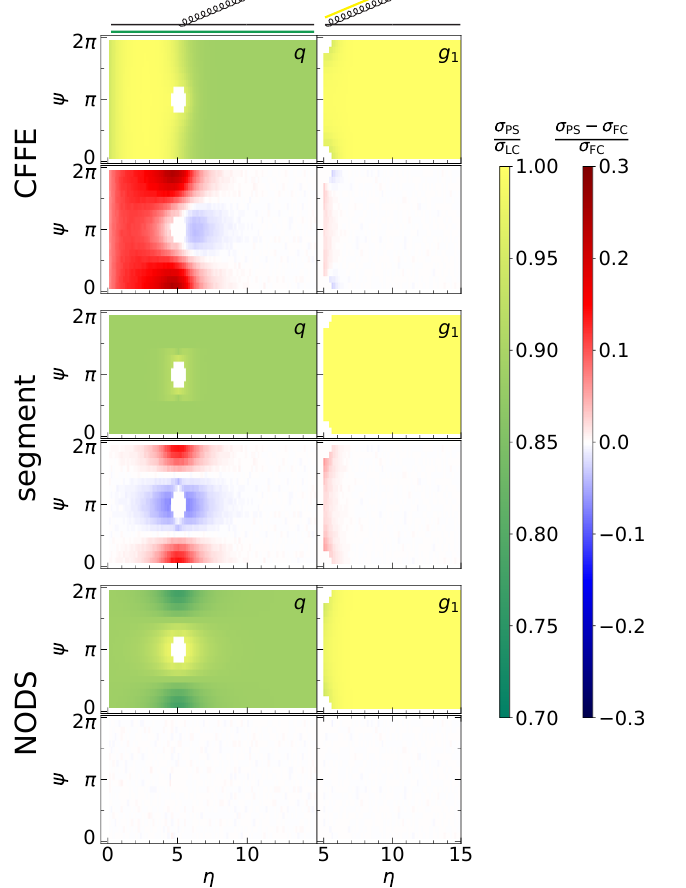
Figure 4. Tree-level fixed-order expansion of the parton shower density for emission of a soft gluon from a ¯ qg system (as represented in figure 2a). The results are shown for the CFFE (top), 1 q segment (middle) and NODS (bottom) colour schemes, as implemented for the PanGlobal shower with β = 0 . The first row in each pair of plots depicts the ratio σ (green-yellow colour PS /σ LC bar). The second row shows the relative deviation ( σ ) /σ between the parton shower PS − σ FC FC and the analytic matrix element (blue-red colour bar). The left-hand panels corresponds to the primary-emission phase-space region, while the right-hand panels corresponds to emission from g , 1 as emphasised in the diagrams at the